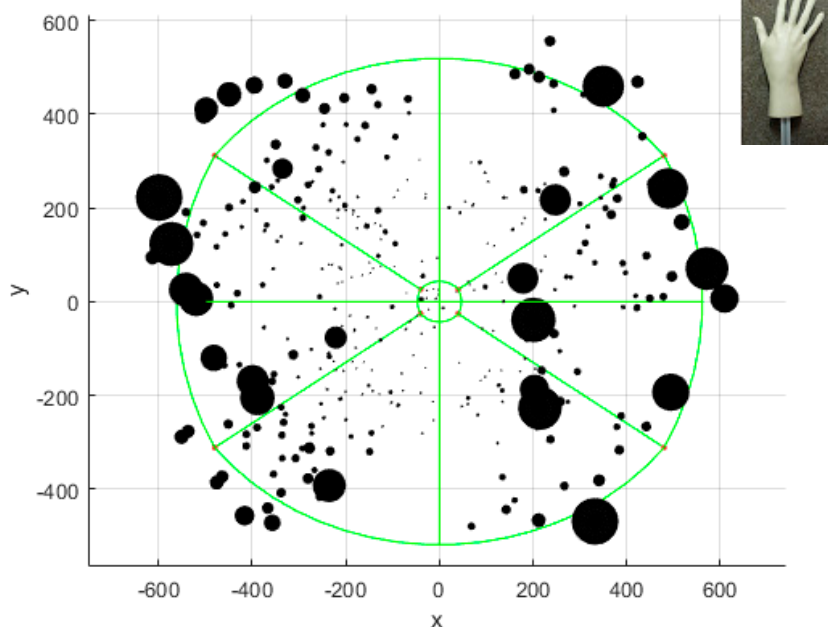
Figure 10. Up to 80 cm: top–bottom view. X and y axis are in mm.